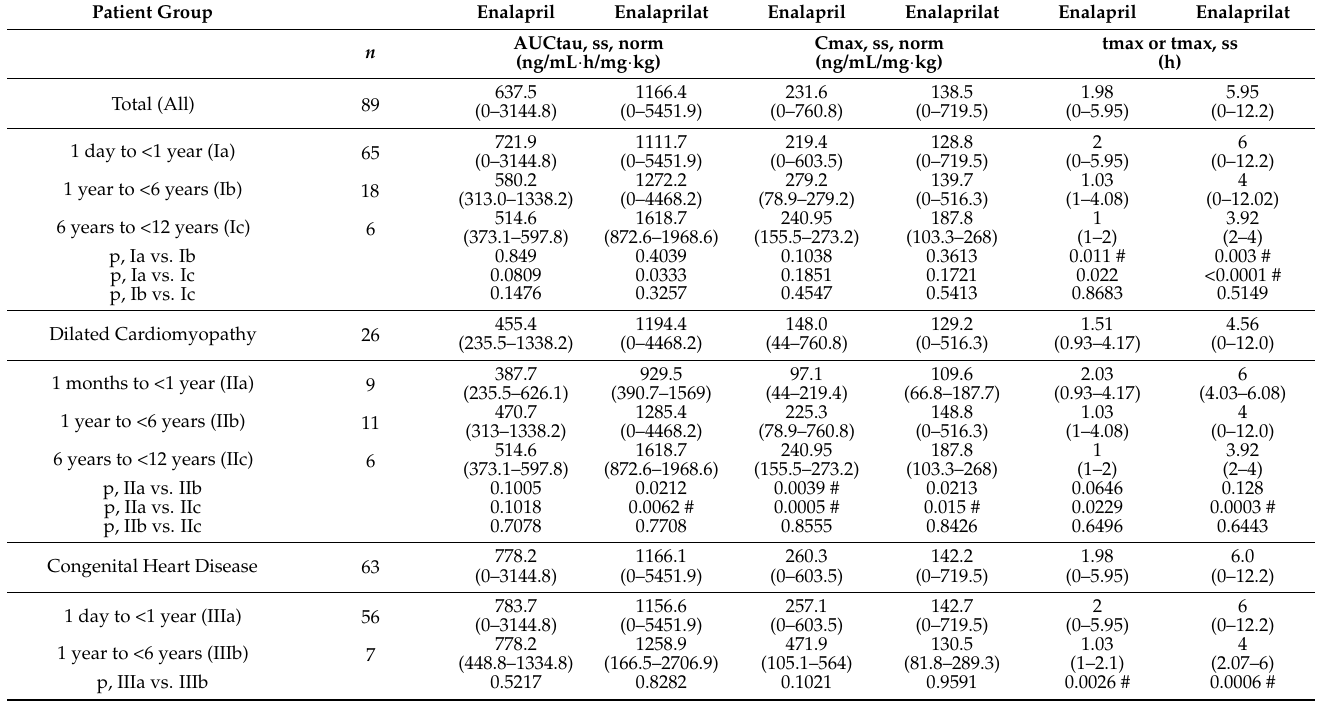
Table 2. Pharmacokinetic parameters of enalapril and enalaprilat in pediatric patients with heart failure due to DCM and